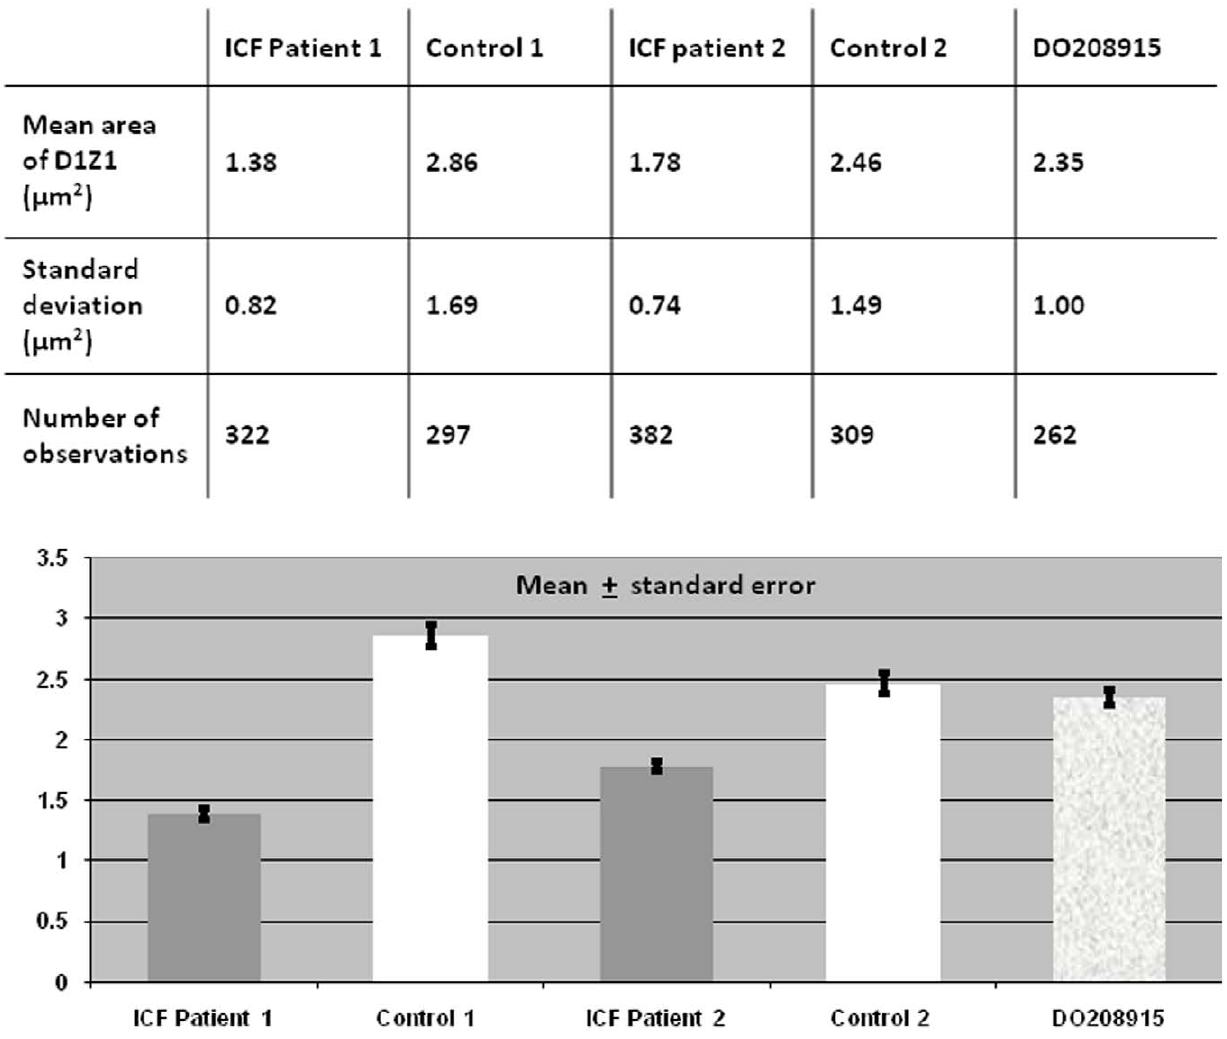
Figure 2. Chromosome 1 juxtacentromeric heterochromatin: area measurements in ICF cells and controls. Measurements of the areas occupied by chromosome 1 juxtacentromeric heterochromatin, as defined by hybridisation with the D1Z1 classical satellite DNA probe, were carried out in hundreds of 2D-fixed interphase nuclei for each cell line and the mean values calculated. The measurements were performed as described in the Materials and Methods. The data sets were compared using a Kolmogorov-Smirnov test, which revealed a statistically significant difference between ICF patients and Controls altogether (D=0.3480, P , 0.001).